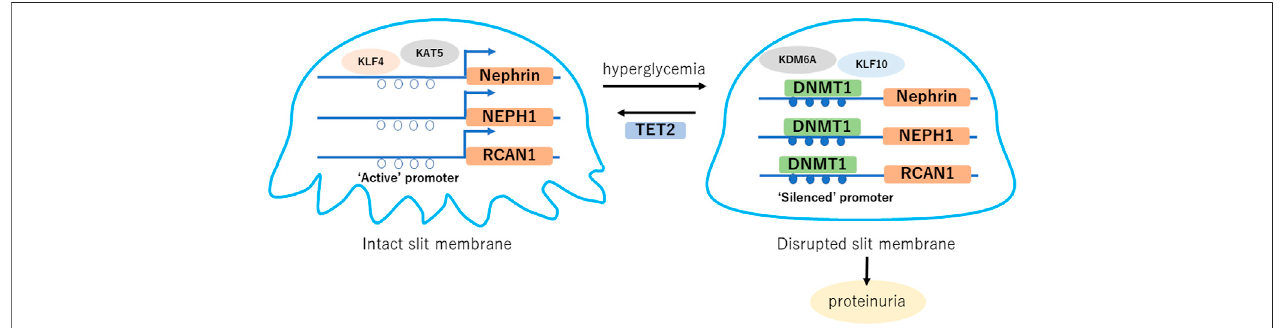
FIGURE 1 | Hyperglycemia induced DNA methylation changes in podocytes. Gene expression such as nephrin, NEPH1 and RCAN1 is maintained with “ active ” promoter, which forms intact slit diaphragm. Hyperglycemia induces DNA methylation of their promoter regions, which causes “ silenced ” promoter and decreased expression, leading disruption of the slit membrane. TET2 is a potential factor of podocyte protection through DNA demethylation of the nephrin and NEPH1 promoter regionsindiabetes.KLF,Kruppellikefactor; KAT5,lysineacetyltransferase5;NEPH1,Nephrin-likeprotein1;KDM6A,lysinedemethylase6A;RCAN1,regulatorof calcineurin 1; DNMT1, DNA metyltransfearse 1; TET2, ten-eleven-translocation